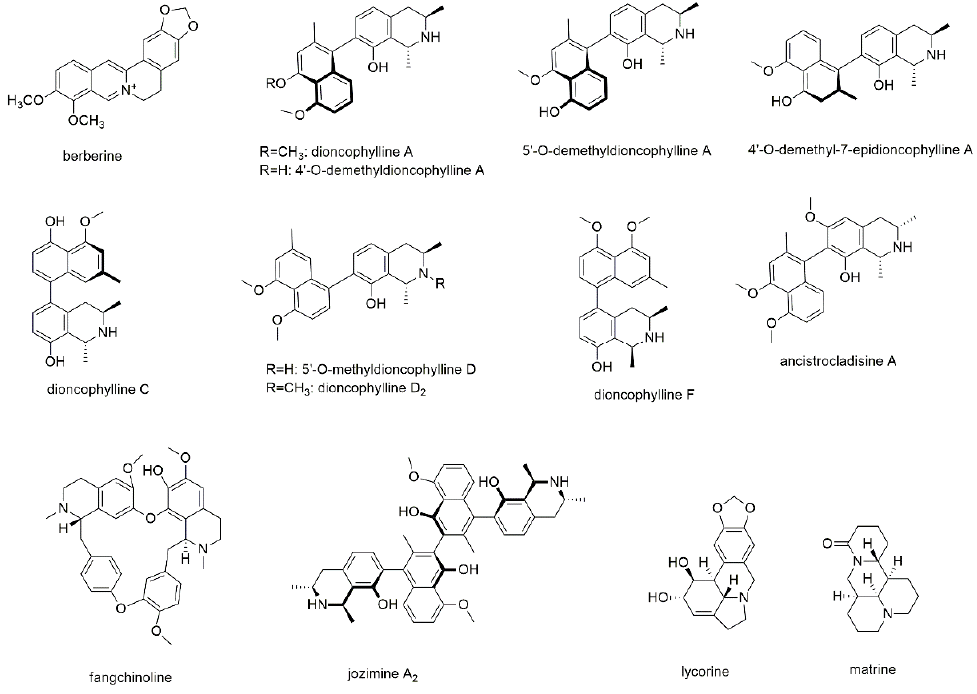
Figure 1. Alkaloids with reported activity against myeloma cell lines.